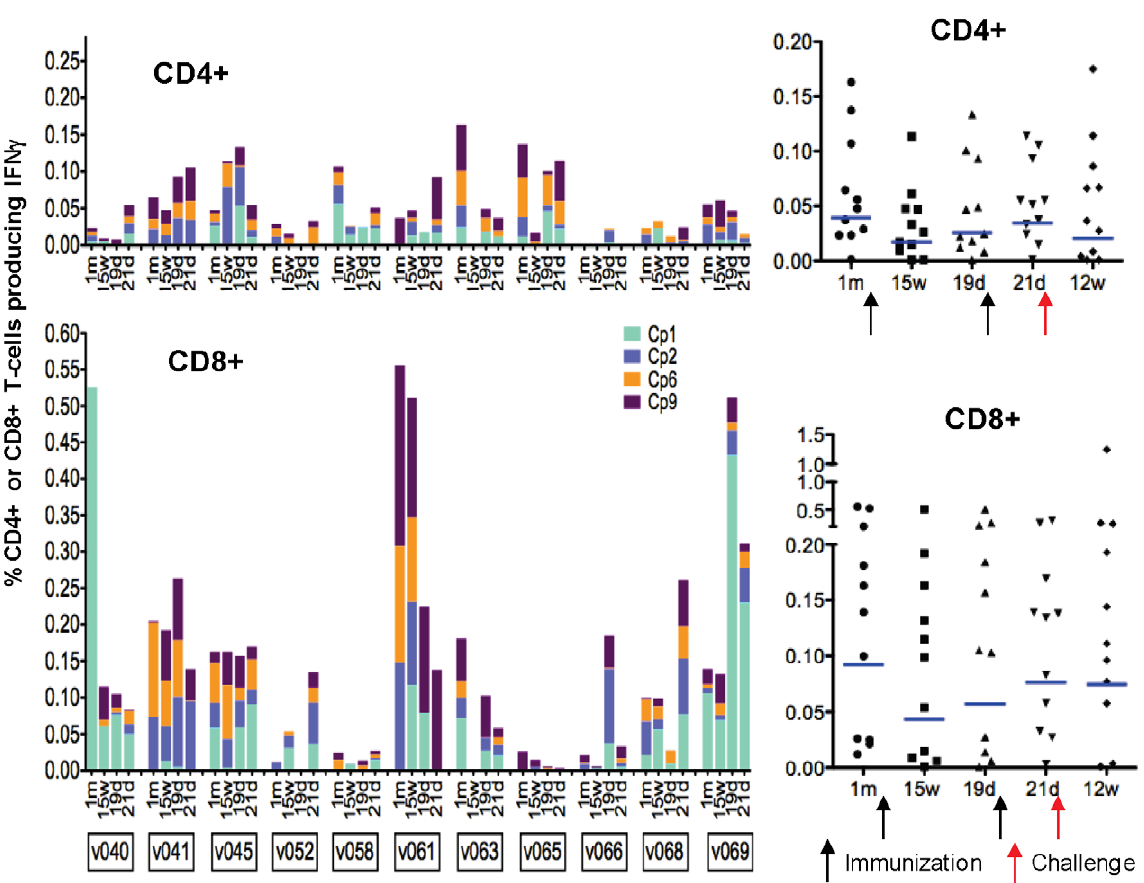
Figure 5. ICS CD4 + and CD8 + T cell IFN- c CSP responses. Percent CD4 + and CD8 + T cells secreting IFN- c in response to CSP for each volunteer at each time point, color-coded by peptide pool. The percents at each time point are plotted for each volunteer along with the geometric means for the group (horizontal bars). Responses prior to immunization are subtracted from all data in order to show only vaccine-induced responses.